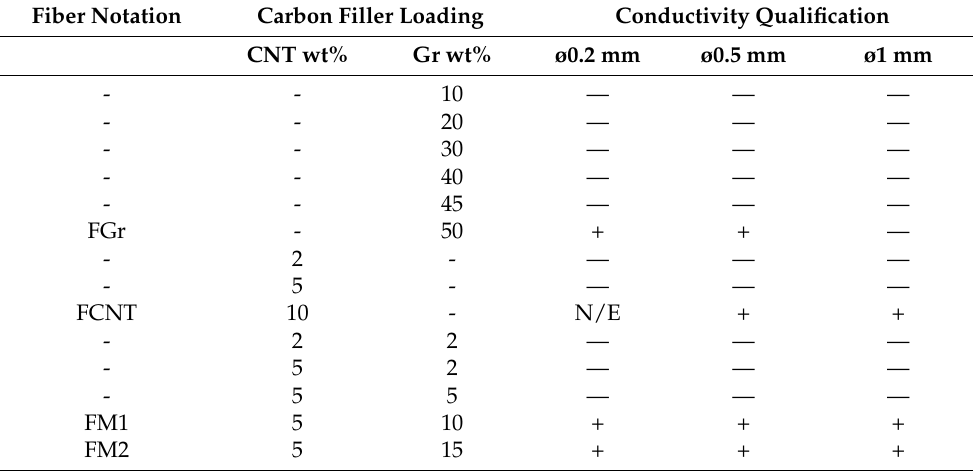
Table 1. Conductive SBS fiber compositions of various CNT and Gr filler loading. Fibers with diameters of 0.2 mm, 0.5 mm, and 1 mm were extruded and assessed based on electrical